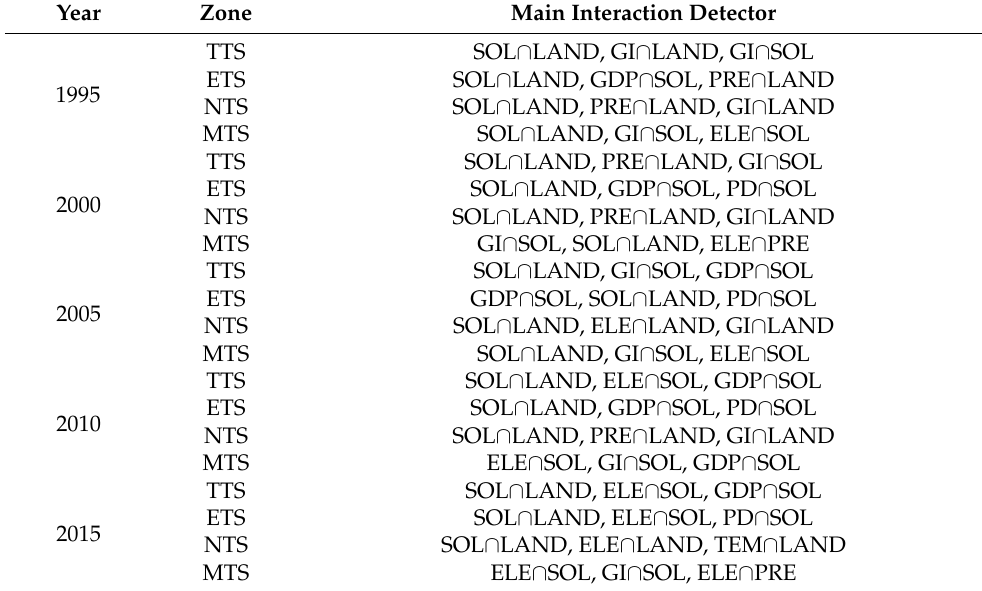
Table 6. The dominant interactions between two driving factors in different